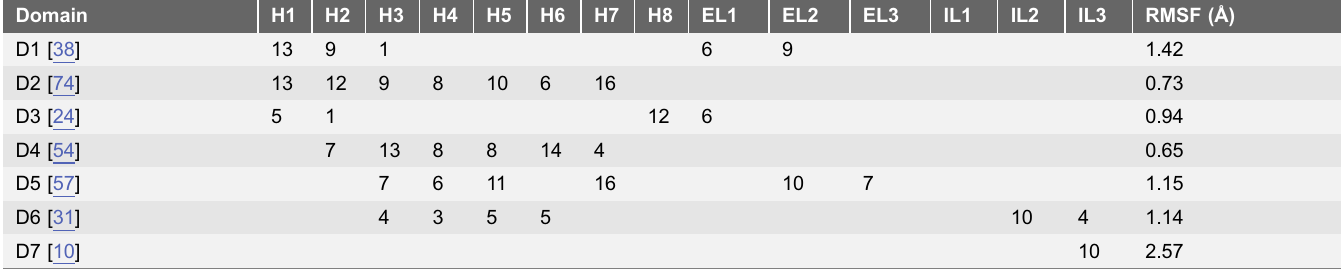
Table 4. Numbers of residues in the helices (H1–H8), ILs, and ELs composing the different domains, i.e. , D1 to D7, as determined with the GeoStaS algorithm applied to the 0.5 m s all-atom m OR MD simulation.